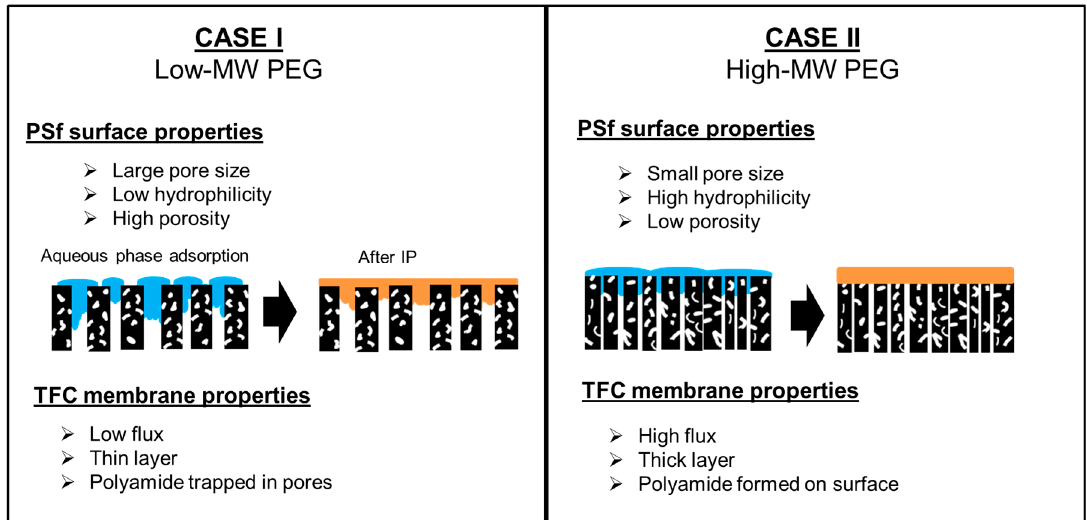
Figure 11. Schematic representation of polyamide formation on two kinds of PSf supports.